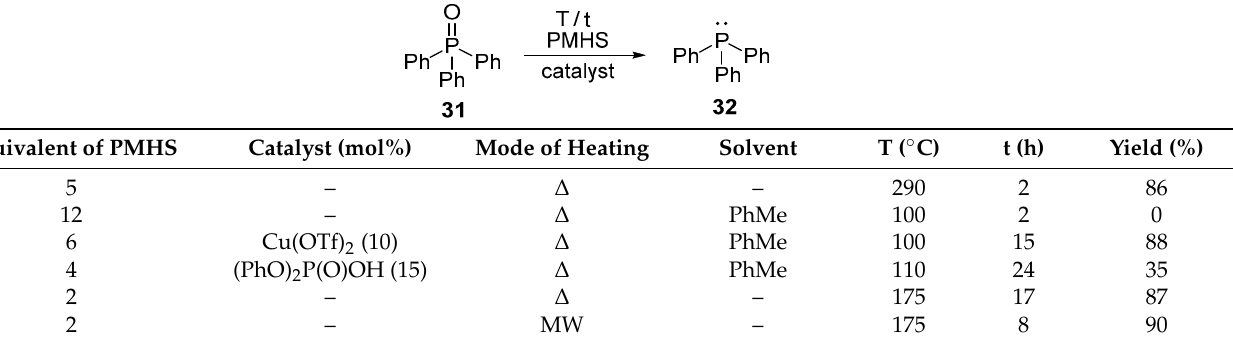
Table 13. Deoxygenation of triphenylphosphine oxide with polymethylhydrosiloxane (PMHS).